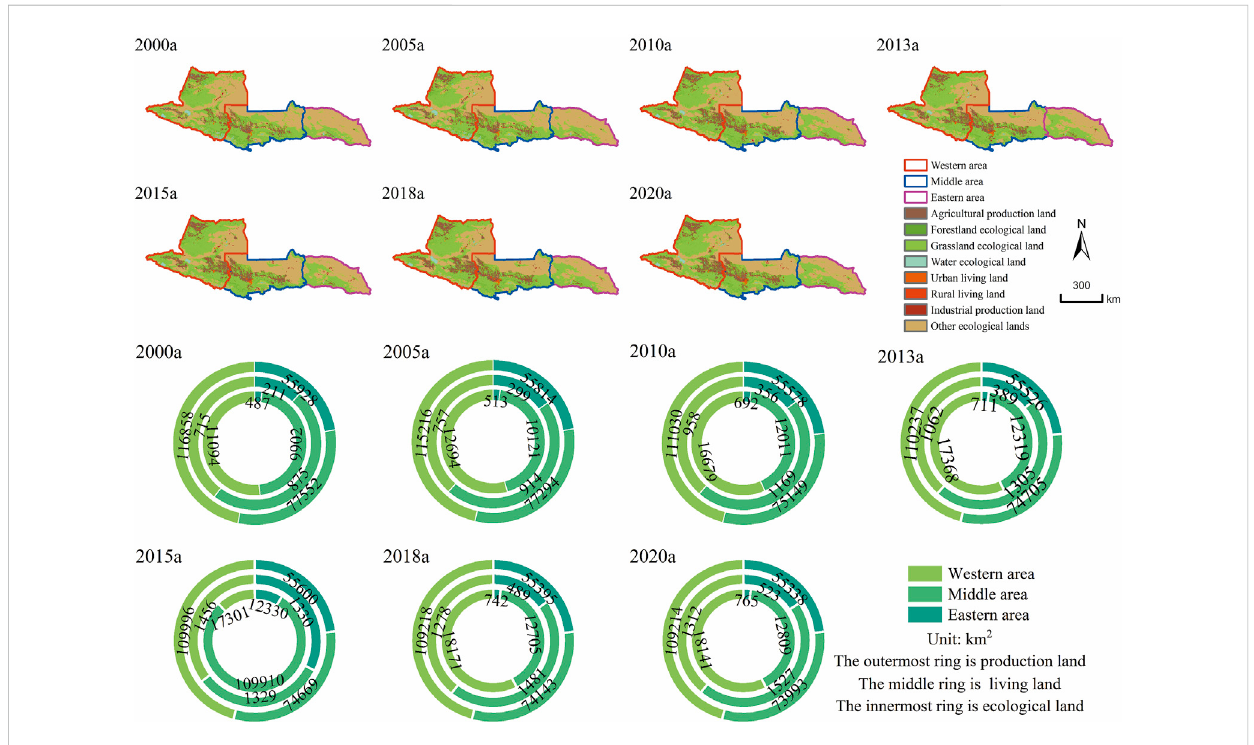
Land use distribution and area on the northern slopes of the Tianshan Mountains from 2000 to